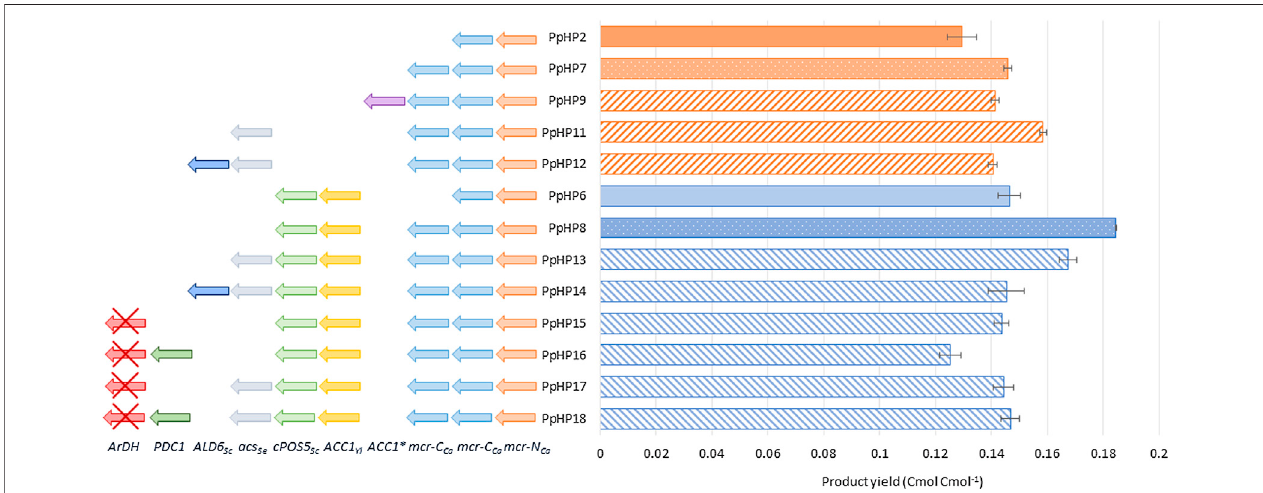
FIGURE 2 | 3-HP production yield of the recombinant P. pastoris strains tested in deep-well plates. The genetic modi fi cations performed to each strain are shown at the left side of the graph. The product yield in Cmol − 1 is shown at the right side of the